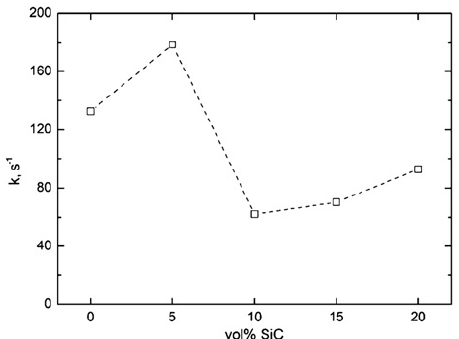
Figure 10. Variation of densification rate as a function of SiC volume fraction for DMLS-processed SiC/Al–7Si–0.3Mg composite powder system [92].